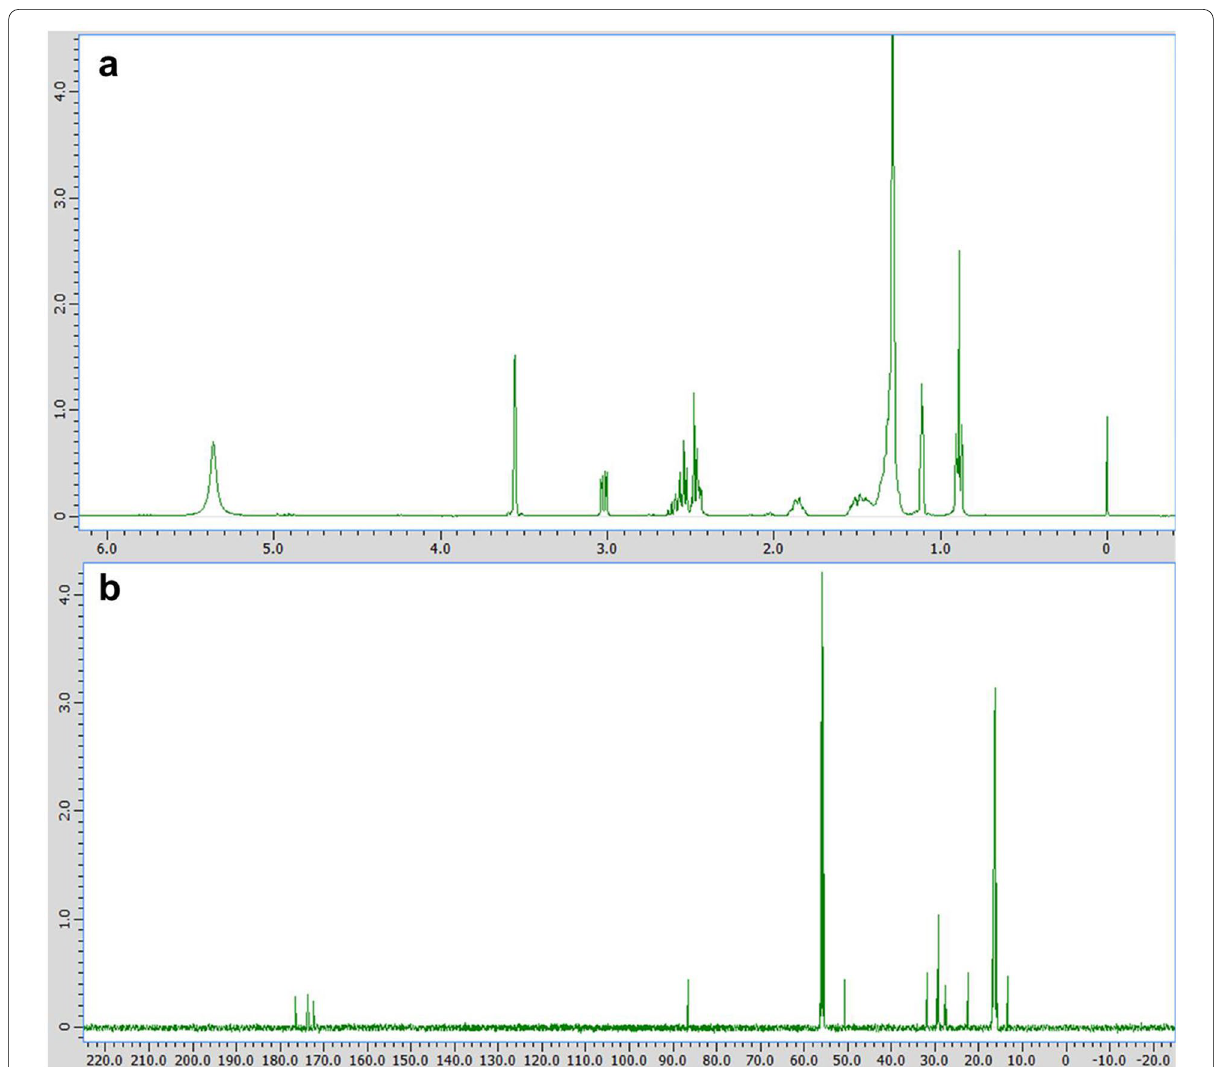
Fig. 3 Analysis of the product from T. trachyspermus NBRC 32238 using NMR. Spectrum data of a 1 H NNR b 13 C NMR. The solvent used was 99.5% ethanol‑d6, and the inner standard was 0.005 v/v%